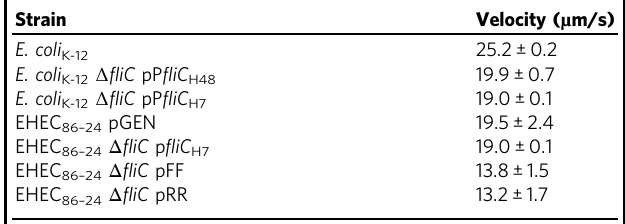
For each strain 50 cells were